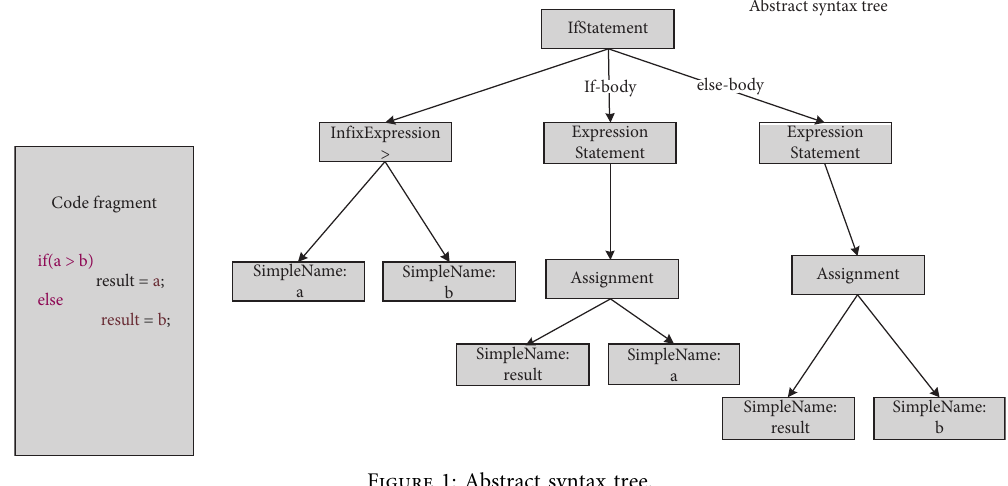
Figure 1: Abstract syntax